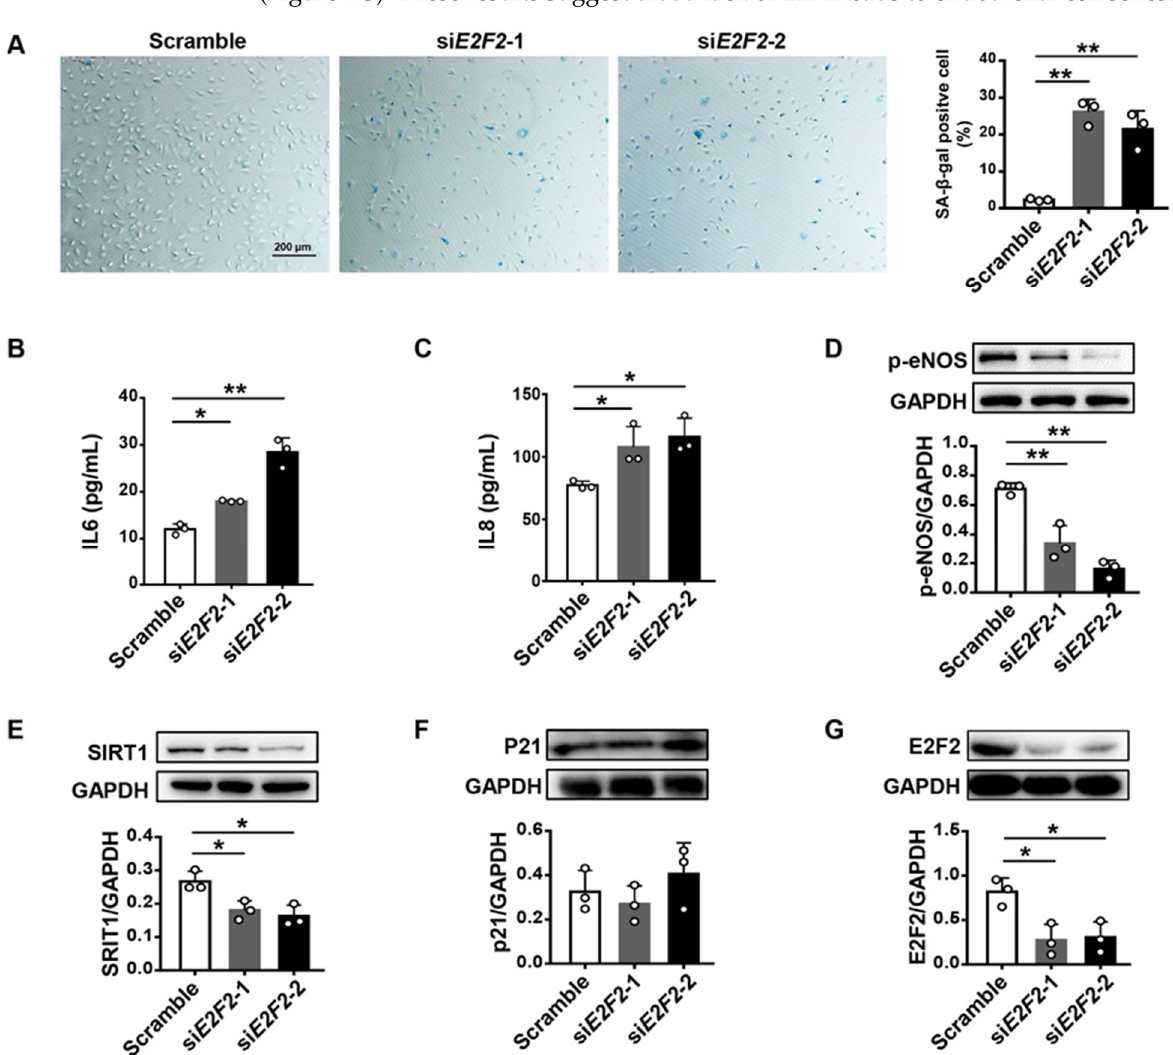
Figure 2. Increased endothelial cell senescence in E2F2 ‐ knockdown HUVECs (PDL12). ( A ) SA ‐β‐ gal staining (blue) for HUVECs transfected with siRNAs (si E2F2 and si E2F2) . Scale bar: 200 μ m. One ‐ way ANOVA for a comparison of the percentage of SA ‐β‐ gal ‐ positive cells. ( B , C ) ELISA for IL6 and IL8 levels in E2F2 ‐ knockdown HUVECs. One ‐ way ANOVA for statistical analysis. Protein expression of p ‐ eNOS ( D ), SIRT1 ( E ), P21 ( F ), and E2F2 ( G ) in HUVECs transfected with two sets of si E2F2 . Protein levels, normalized to GAPDH, were estimated by densitometry. Statistical analysis was performed with one ‐ way ANOVA. Values are mean ± S.D. * p < 0.05, ** p < 0.01.